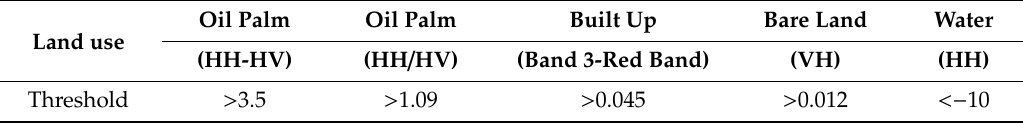
Table4. Satellitedata(opticalandradar)thresholdvaluesfordifferentlanduse / coverinPeninsularMalaysia. Oil Land use